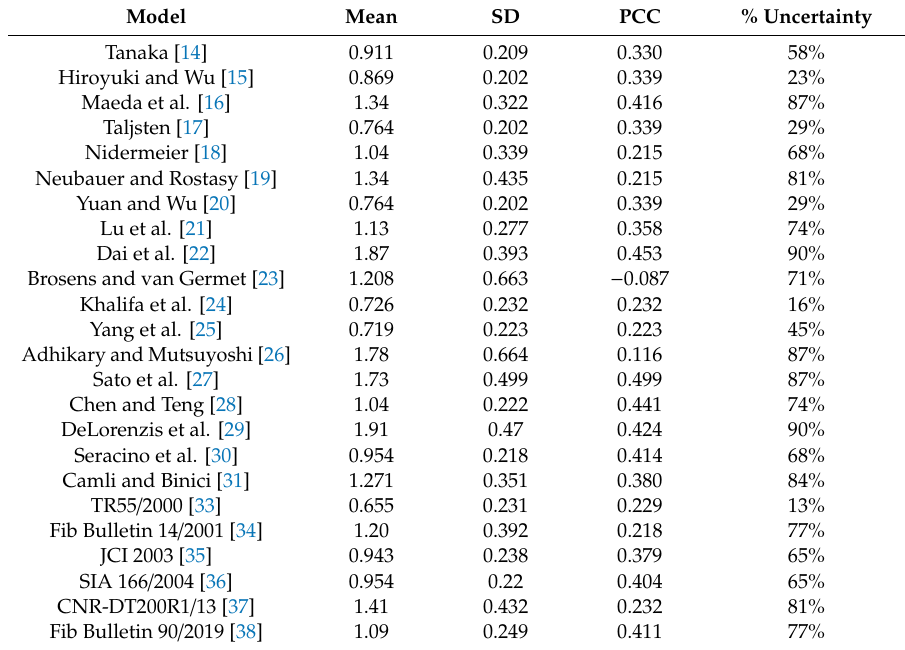
Table 5. Summary of results—predicted to experimental bond strength ratios for SRP composites bonded to